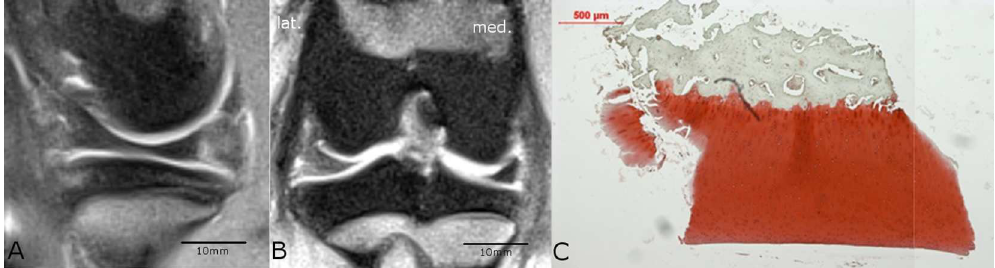
knee (A) nor in the coronal MRI-scan (B). The scale bars for A and B were determined with the program RadiAnt DICOM viewer (see caption Fig 1). The histological safranin-o staining (C) showed a normal cartilage tissue (Little- score: 0 points). The histological and MRI results did match.